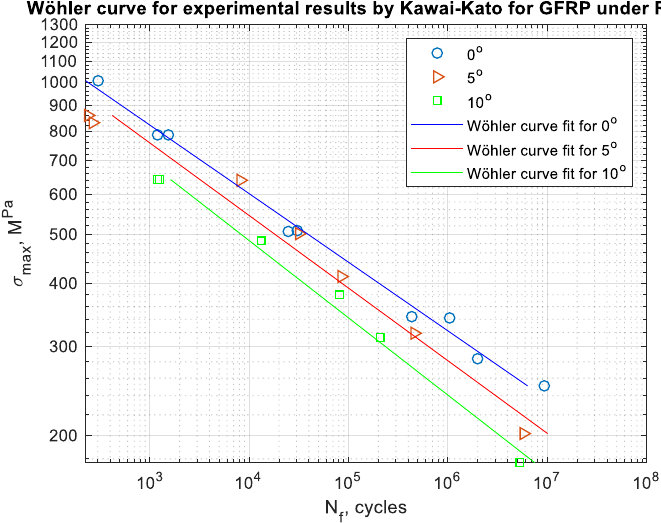
Figure 5. S – N curves for experimental results by Kawaii – Kato for GFRP for the fiber orientation 0, 5, Figure 5. S–N curves for experimental results by Kawaii–Kato for GFRP for the fiber orientation 0, 5, and 10 degrees and R = 0.1. and 10 degrees and R = 0.1.